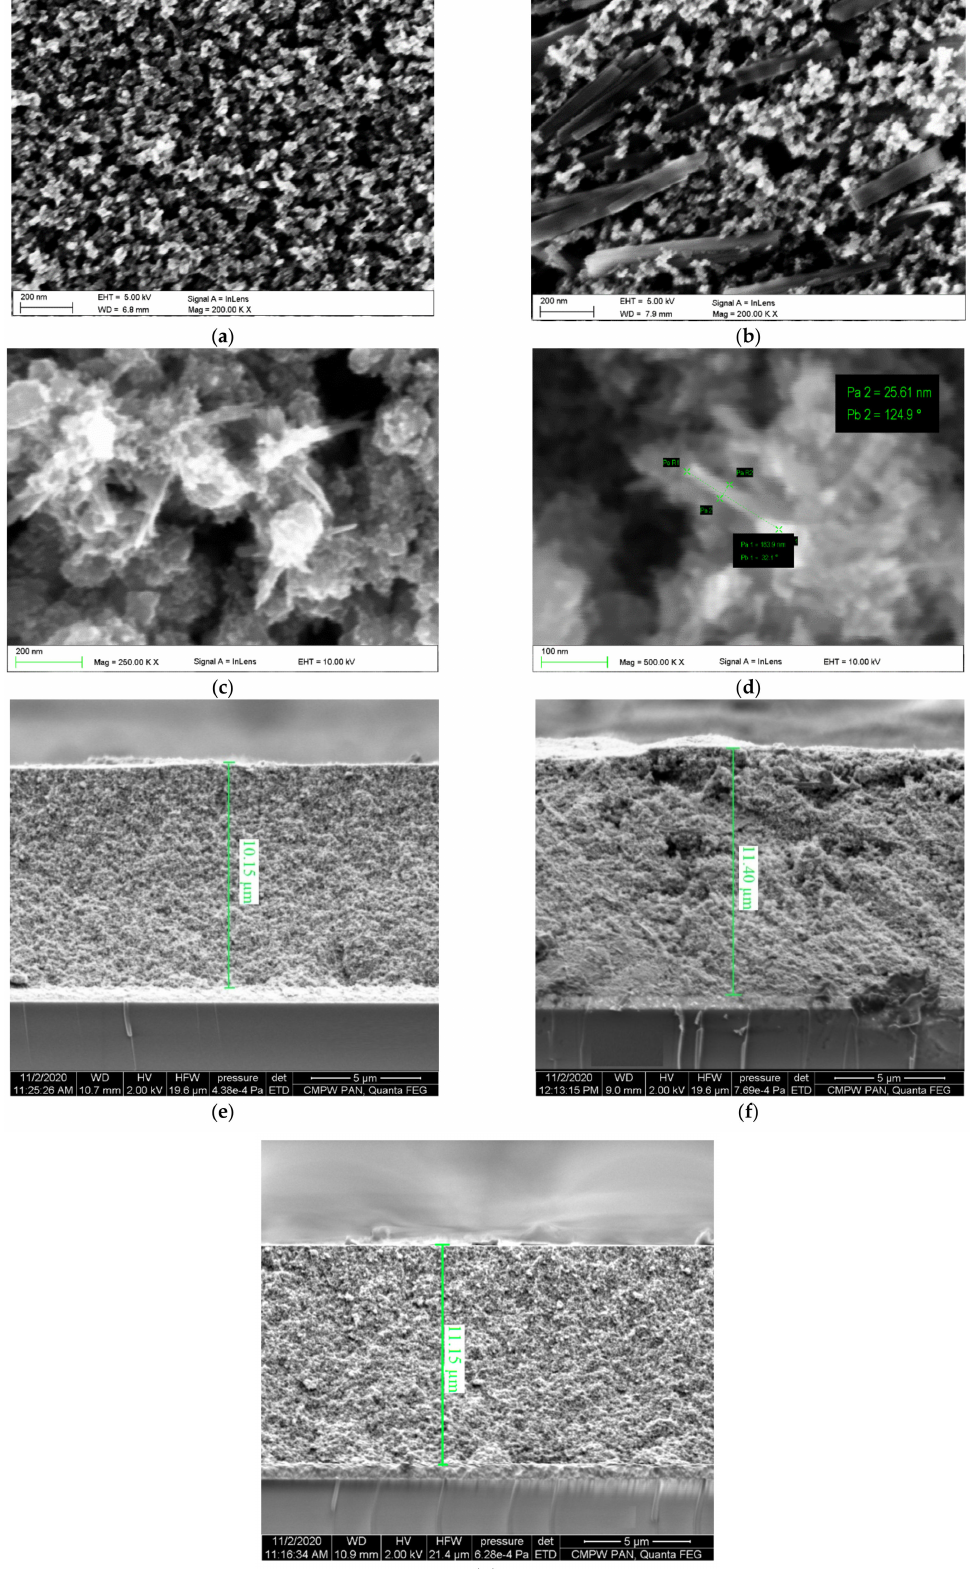
Figure 3. The SEM images of the surface of the TiO 2 layers containing: ( a ) NPs, ( b ) TiO 2 NPs-NWs, ( c , d ) TiO 2 NPs-NTs and cross-sectional SEM images of ( e ) TiO 2 NPs, ( f ) TiO 2 NPs-NWs and ( g ) TiO 2